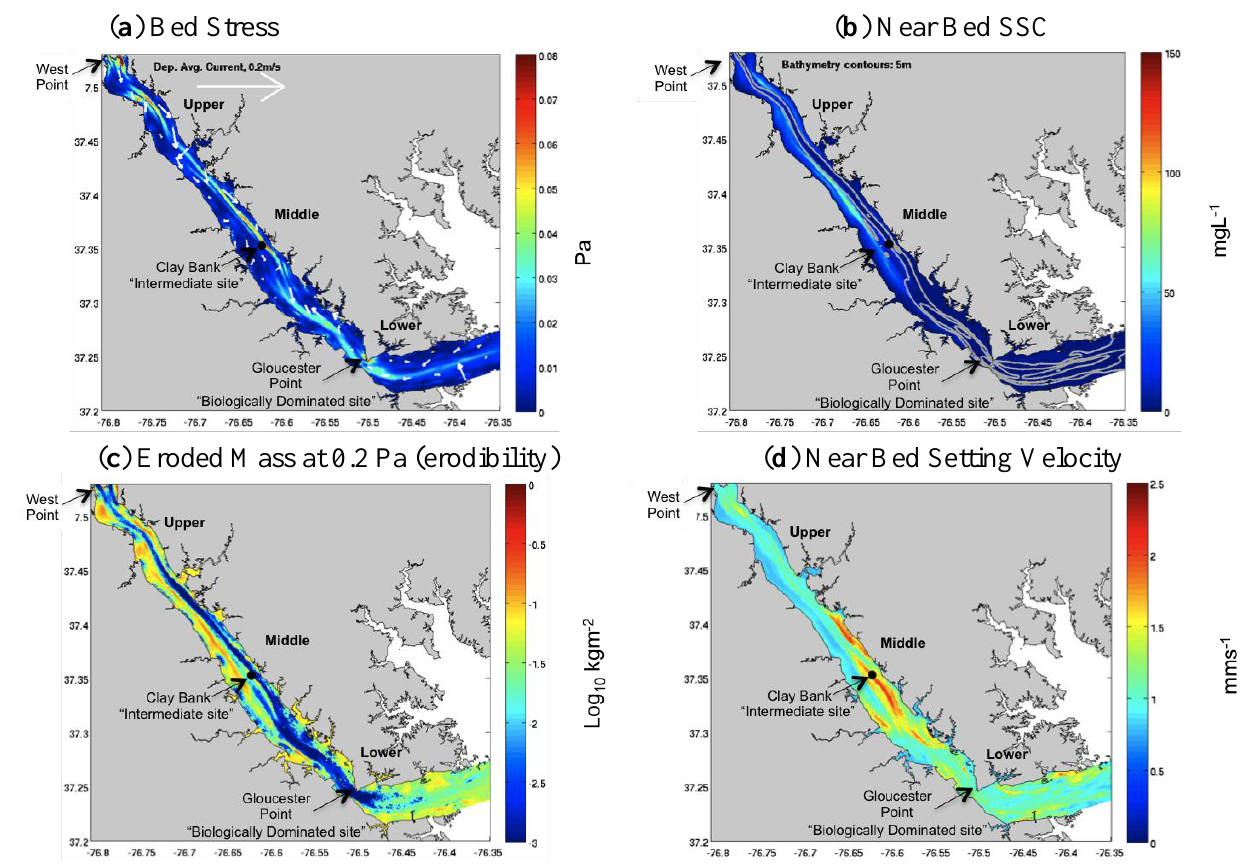
Figure 5. Daily-averaged model estimates of ( a ) bed stress, ( b ) near bed suspended sediment concentration, ( c ) mass eroded at 0.2 Pa and ( d ) near bed settling velocity during a neap tide when lower erodibility was found mid-estuary (25 July